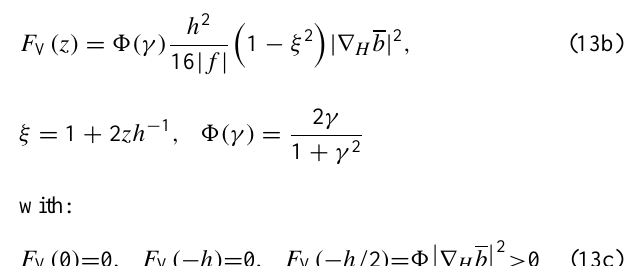
(z) for the ICC0 simu- V